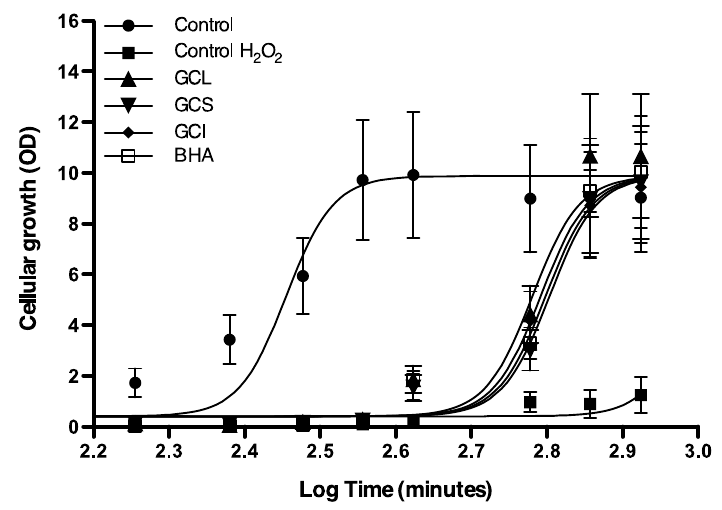
Figure 4. Cellular growth during 16 hours of S. cerevisiae in YPD medium (filled circles), O (filled squares), YPD medium with 0.1 mM H YPD medium with 0.1 mM H 2 2 GAE mL − 1 of green cultivated leaves (GCL) (filled triangles), green cultivated stalks (GCS) (inverted filled triangles), green cultivated inflorescence (GCI) (filled diamond) and 25 µg·mL − 1 2- tert -butyl-4-methoxyphenol (BHA) (open squares). Each value represents the mean ± S.D. of three determinations.